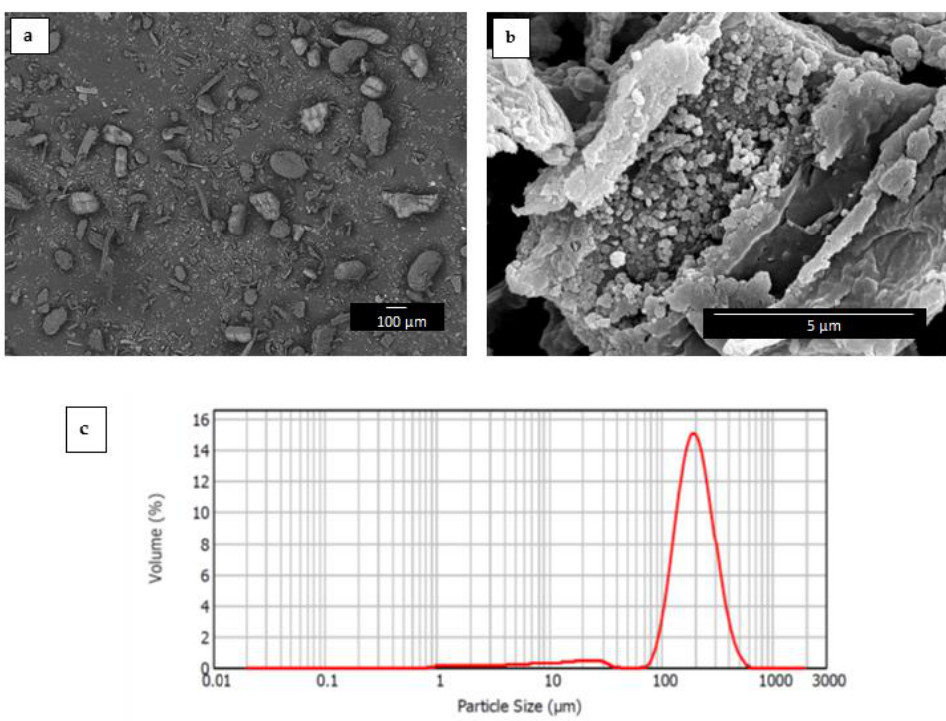
Figure 2. Scanning electron microscopy (SEM) images of rice husk flour (RHF) taken at ( a ) 50× with scale marker of 100 µm and ( b ) 10,000× with scale marker of 5 µm; ( c ) particle size histogram of RHF.